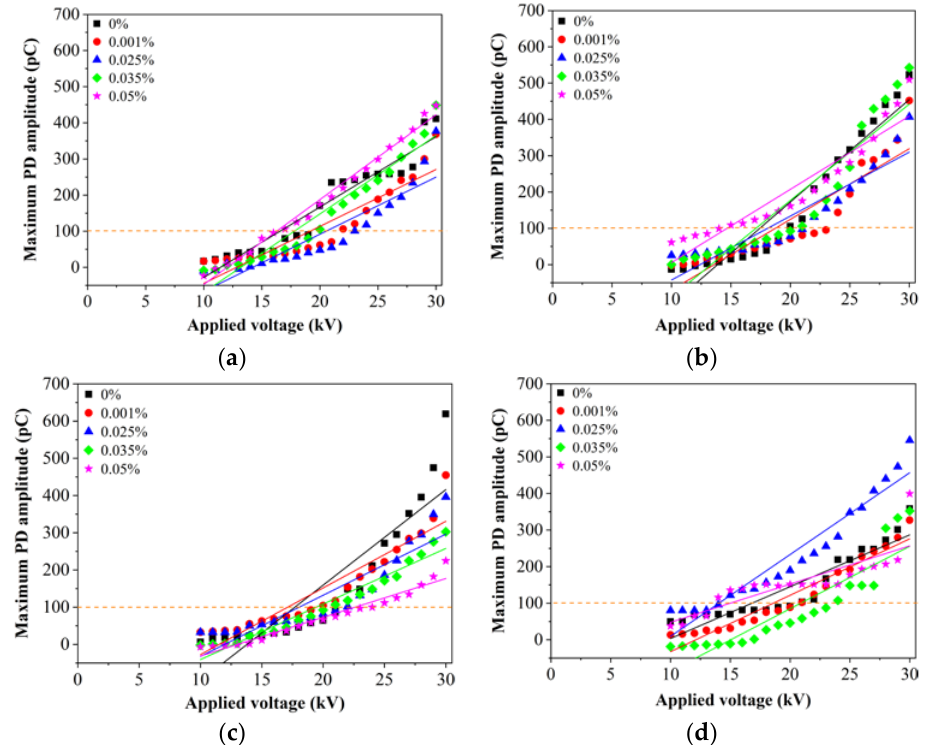
Figure 5. Maximum PD amplitude versus applied voltage for ( a ) RBDPOA, ( b ) RBDPOB, ( c ) CO, and ( d ) MO based Al 2 O 3 without SDS.